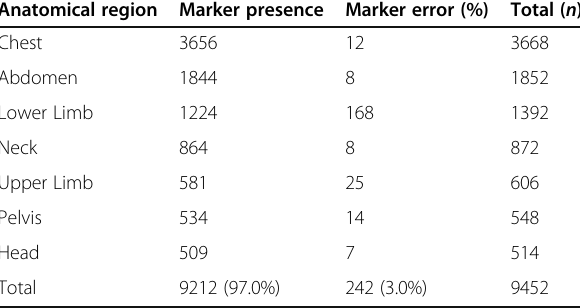
Table 2 Anatomy-specific location of ASM on images Anatomical region Marker presence Marker error (%) Total ( n